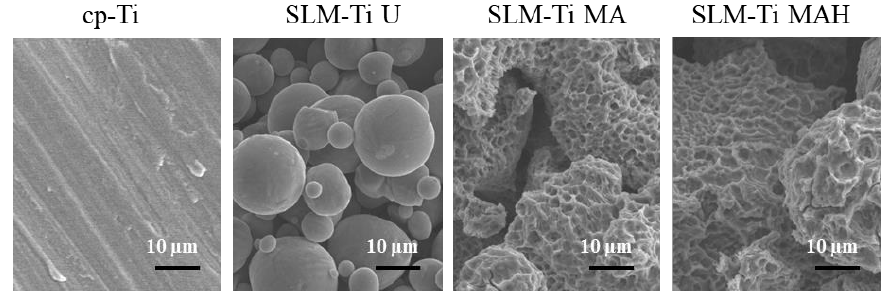
Figure 1. SEM images of cp-Ti and SLM-Ti before and after treatment with mixed acid and heat.